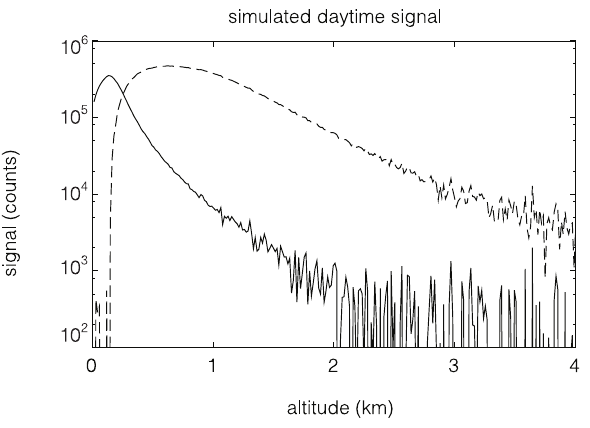
Fig. 2. Simulated water vapour Raman lidar signal for 2 min integration time with the small telescope (solid line), and for 30 min integration time with the large telescope (dashed line). A random statistical error with Poisson distribution was added to simulate photon count